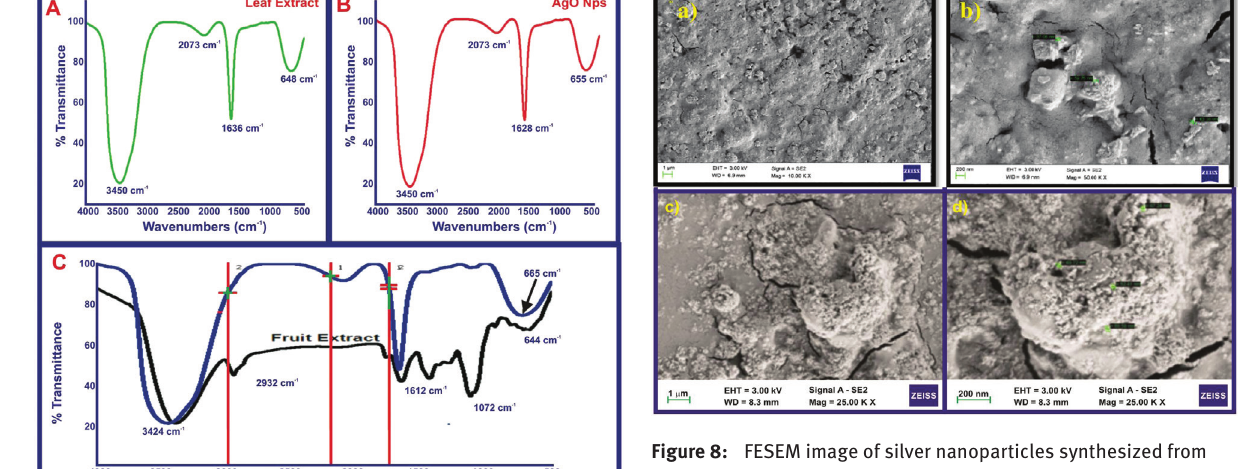
Figure 8: FESEM image of silver nanoparticles synthesized from Plum fruit